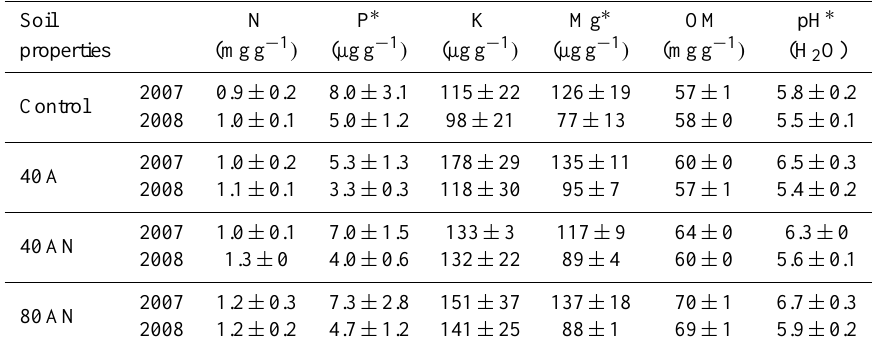
Table 1. Soil surface (0–15cm) properties (N, phosphorus – P, potassium – K, magnesium – Mg – and organic matter concentrations – OM – and pH) at the first (May 2007) and second (April 2008) springs after the beginning of the experiment according to the distinct N additions (Control, 40A, 40AN and